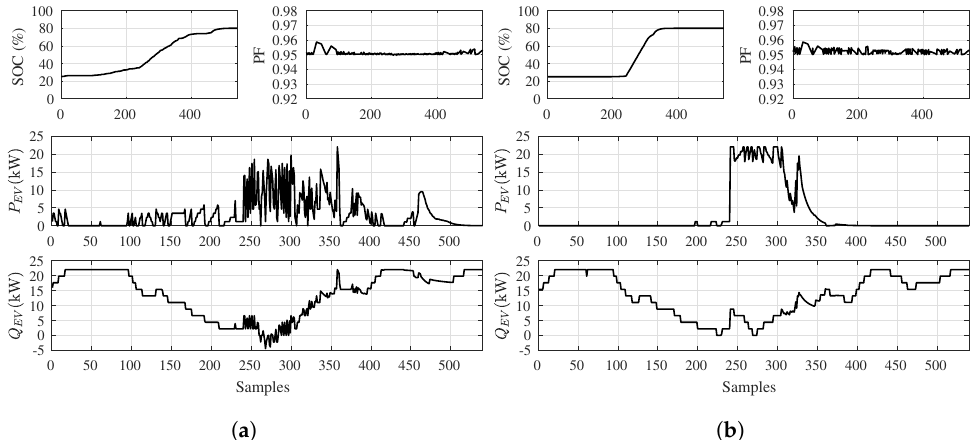
Figure 6. Impact in state and control variables by changing the γ and β weights applying ( a ) α = 100, γ = 10, and β = 1 ( b ) and α = 100, γ = 1, and β =